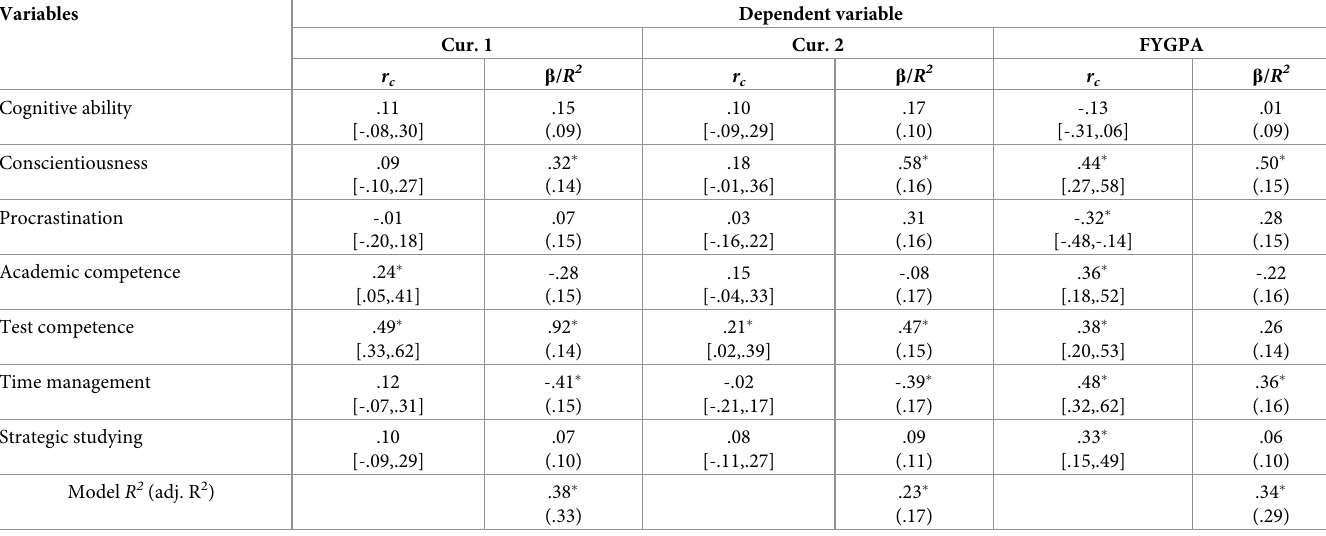
Table 6. Construct saturation multiple regression results based on correlations corrected for